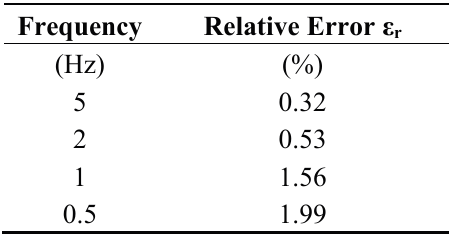
Table 5. Relative error of MEMS